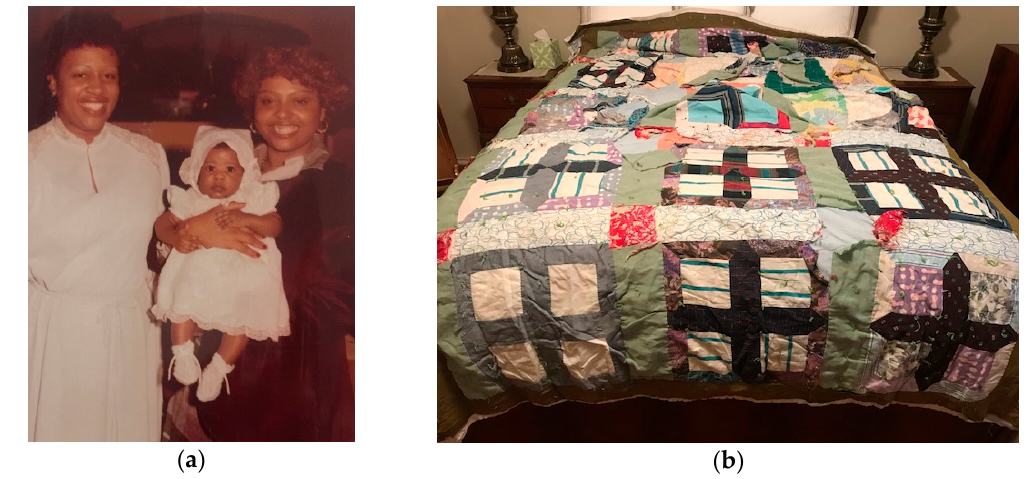
Figure 1. ( a ) My Aunt Sandra ( left ) and my Aunt Sissy ( right ) with me at my christening at Second Calvacade Church in Fifth Ward, Houston Texas; (b) One of my grandmother’s, Annie Lou Tatum’s, quilts at my parents’ home in Houston,